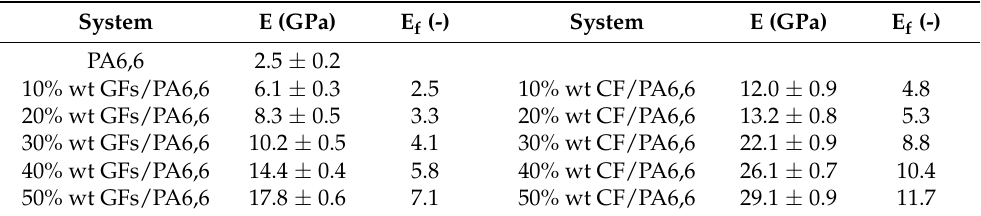
Table A2. Values of the Young modulus E and the corresponding enhancement factor E f (=E of the (nano)composite/E of the pristine polymeric matrix) for the system based on Nylon 6,6 (PA6,6) and